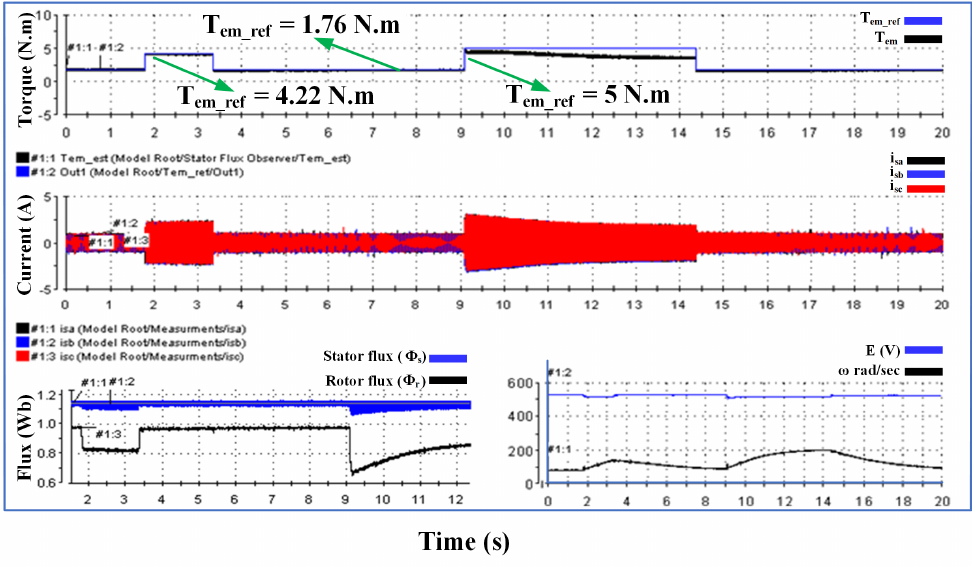
Figure 33. The performance of DTSFC with successive steps of the reference torque.